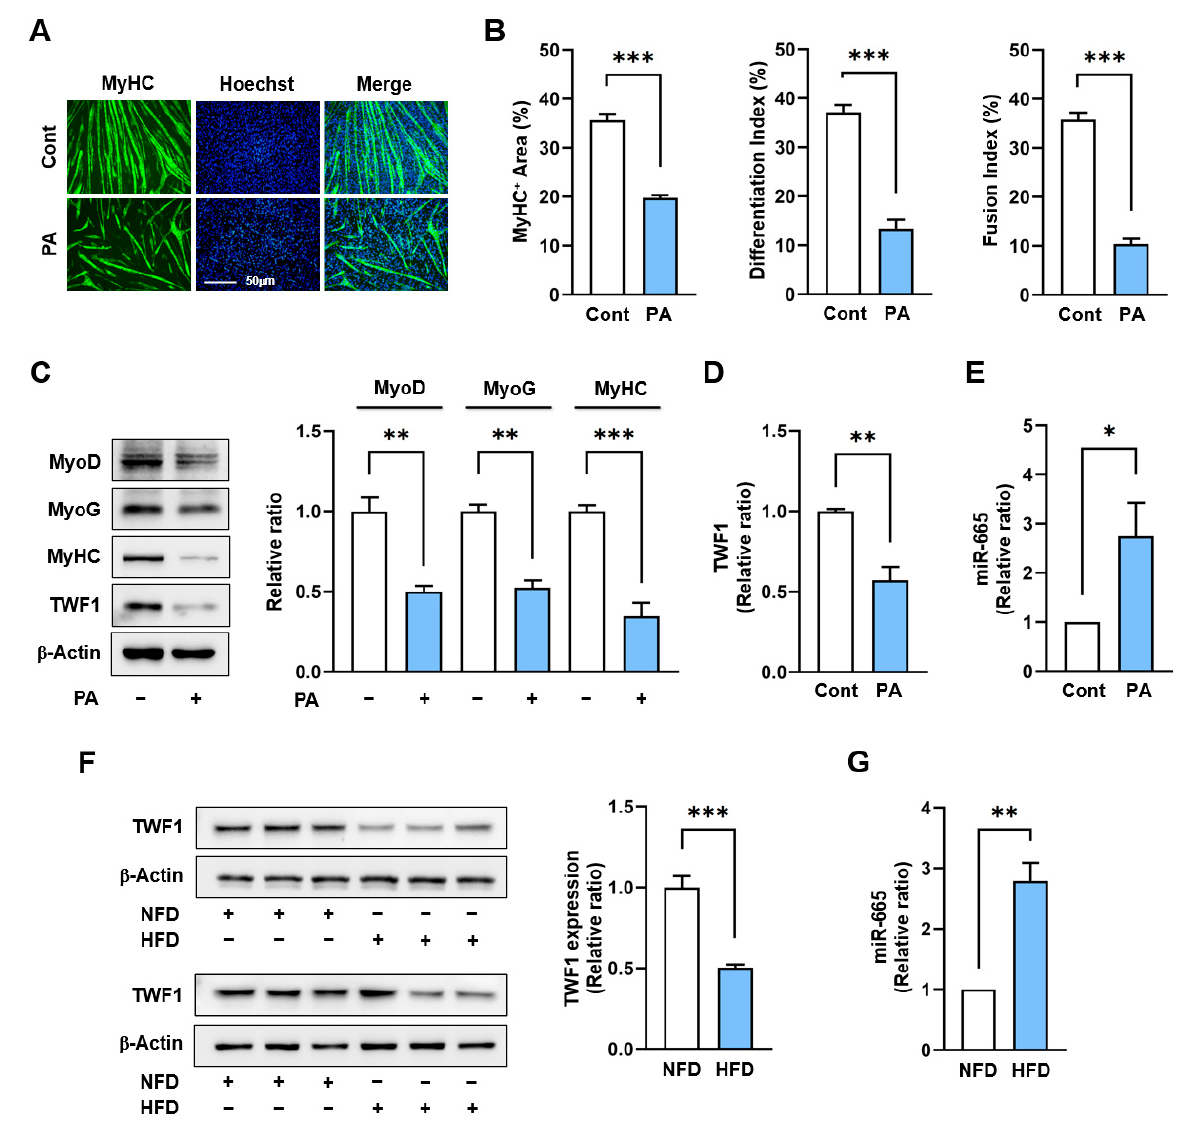
Figure 1. PA inhibited C2C12 differentiation and upregulated miR-665-3p expression. C2C12 cells were treated with PA (100 μ M) or vehicle control for 24 h before inducing differentiation. ( A ) After differentiation for five days, immunofluorescence staining with MyHC (green) was used to analyze myogenic differentiation. Nuclei were counterstained with Hoechst 33,342 (blue). Scale bar: 50 μ m. ( B ) Myotube formation was quantified based on the results of ( A ) using MyHC-positive area, differentiation indices, and fusion indices. ( C , D ) The expressions of myogenic factors and TWF1 were analyzed on day three of differentiation. Expression levels were normalized versus β -actin. ( E ) The expression of miR-665-3p was analyzed 24 h after PA treatment by q RT-PCR and normalized to U6. ( F ) The representative immunoblots (6 mice/group) of TWF1 in the gastrocnemius muscle of NFD-fed mice and HFD-fed mice are shown. ( G ) The expression of miR-665-3p in the gastrocnemius muscle of NFD-fed mice (open column) and HFD-fed mice (closed column) was analyzed by q RT-PCR and normalized to U6. The values are expressed as the relative ratio, where the intensity of the vehicle control was set to one. Data are presented as means ± SEMs ( n = 3 except mice experiment ( n = 6); * p < 0.05; ** p < 0.01; *** p < 0.001 vs. control or NFD).